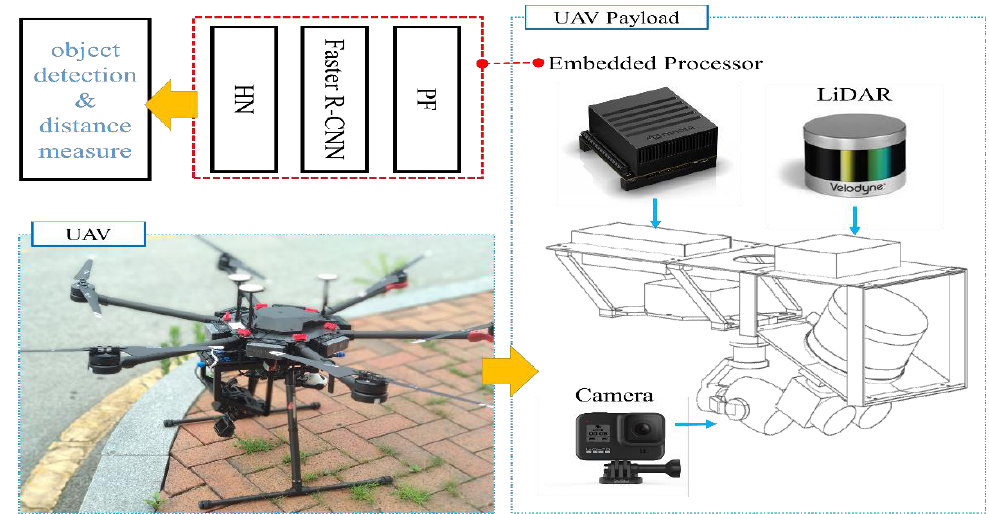
Figure 5. Unmanned Aerial Vehicle (UAV) designed for real-time data collection, processing, and test evaluation using RGDiNet.